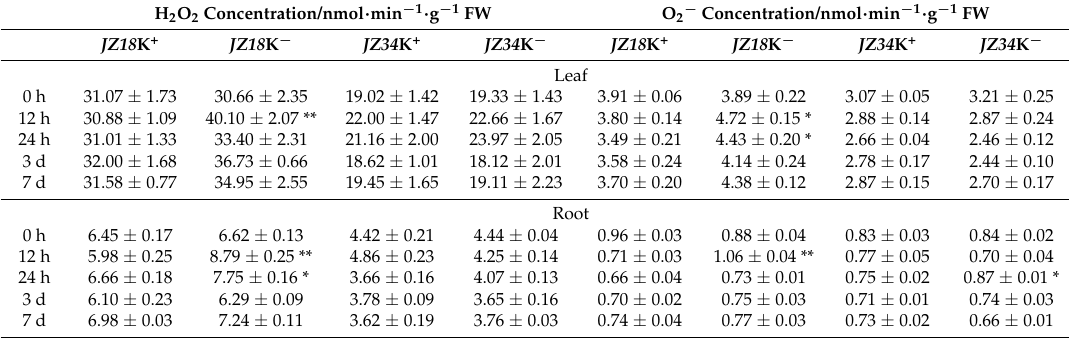
Figure 6. Comparison of the reactive oxygen species (ROS) content in the guard cells ( A ) and roots ( B ) of different tomato varieties under K + -deficiency stress conditions at 0 h, 12 h, 24 h, 3 d, and 7 d. K + represents normal K + (4 mM); K − represents K + deficiency (0.5 mM). The experiments were repeated three times. ( A ) Scale Bar: 10 µ m ( B ) Scale Bar: 30 µ m. Table 5. H 2 O 2 and O 2 − levels in the leaves and roots of JZ18 and JZ34 under K + -deficiency stress conditions at 0 h, 12 h, 24 h, 3 d, and 7 d. K + represents normal K + (4 mM); K − represents K + deficiency (0.5 mM). The experiments were repeated three